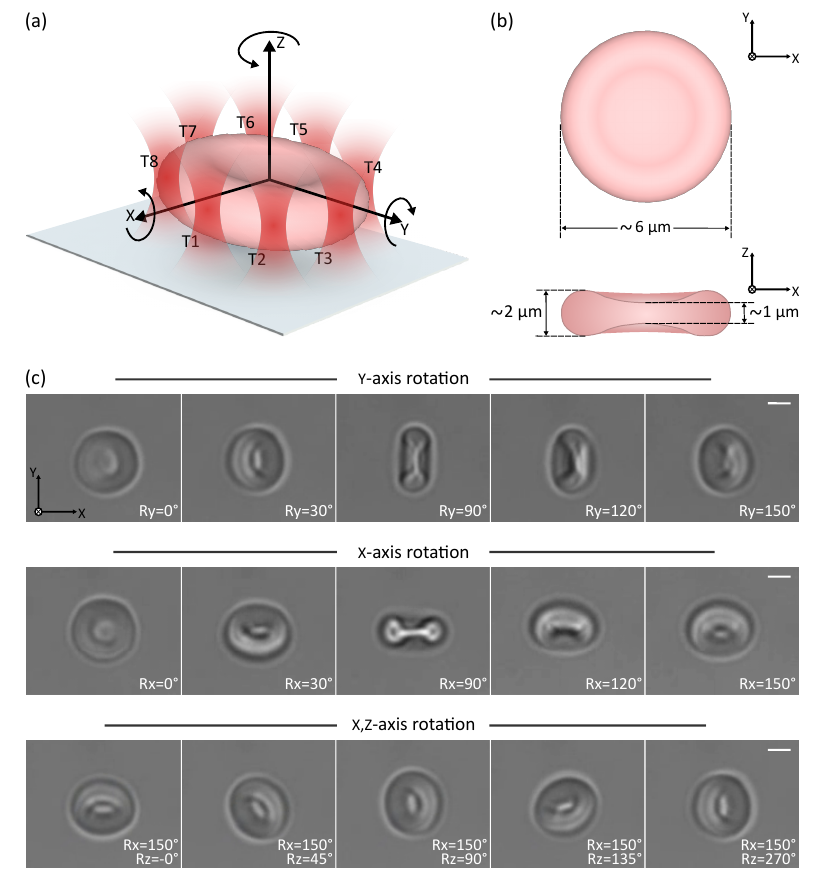
Figure 7. 3D rotation control of erythrocyte driven by 8 optical traps. ( a ) Schematic 3D depiction of erythrocyte and the reference frame used in the 3D control. ( b ) Schematic 2D depiction of the erythrocyte with dimensions in y–x and z–x plane. ( c ) Time-lapse images from Supplementary Videos S1 and S2 demonstrating multiple degrees-of-freedom cell rotational control. Scale bar is 2 µm